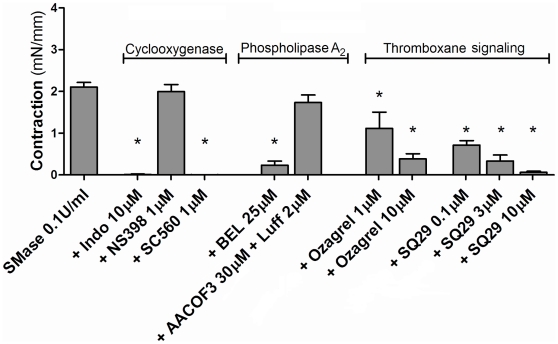
Characterization of SMase-induced contraction in SHR carotid artery.SMase-induced contraction, in absence and presence of the non-specific COX inhibitor indomethacin (Indo), COX-1 specific inhibitor SC560, COX-2 specific inhibitor NS398, the PLA2 inhibitors AACOF3 (cPLA2) and Luffariellolide (Luff; sPLA2), Bromoenol lactone (BEL; iPLA2), the thromboxane synthase inhibitor Ozagrel and the thromboxane receptor antagonist SQ29548 (SQ29). Data presented as mean ± SEM, n = 4–6, (*) p<0.05 compared to control SMase.